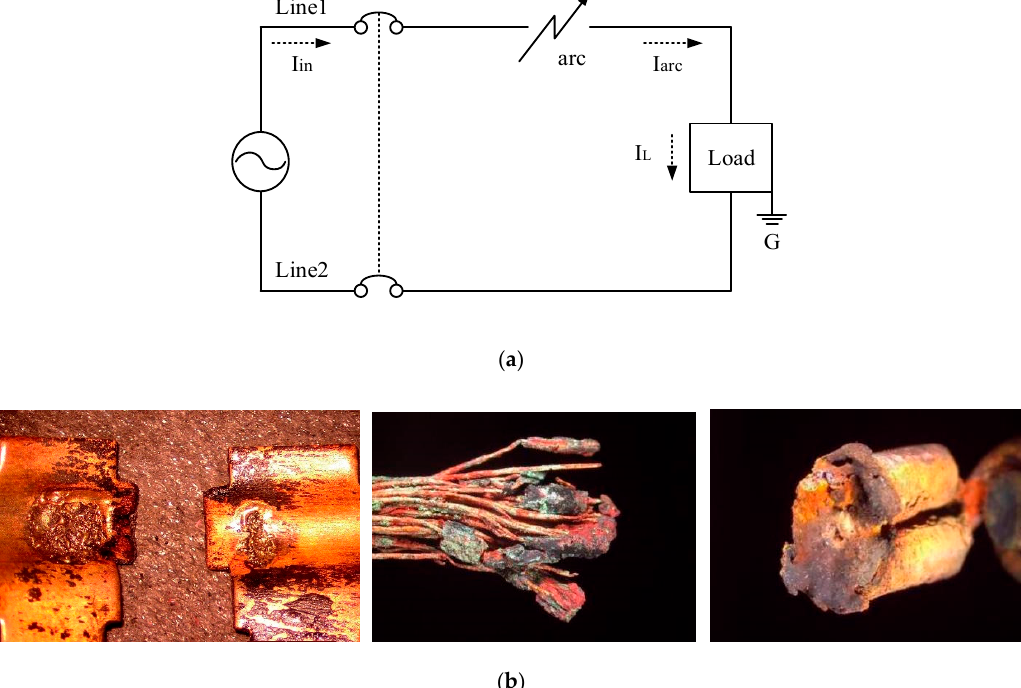
Figure 2. Series arc. ( a ) A circuit; ( b ) evidence of accidental fires caused by series arc.